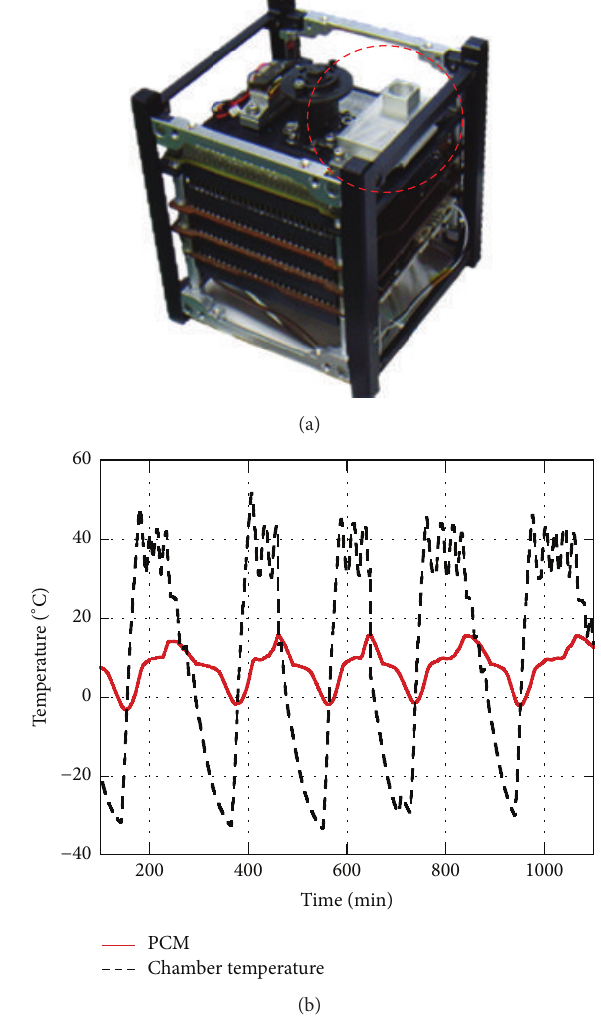
Figure 2: Variable emissivity radiator (VEM).